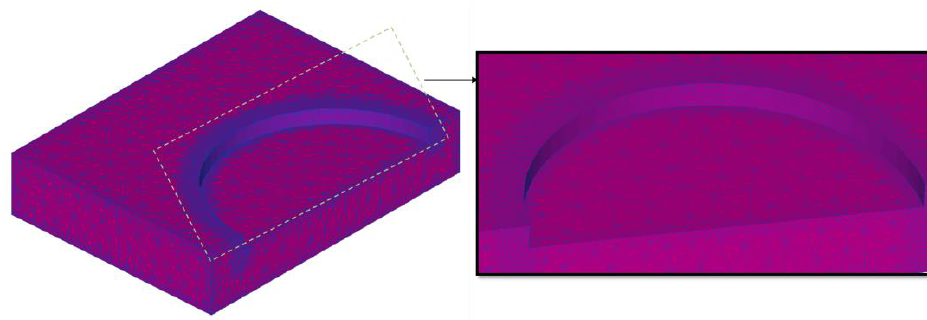
Figure 5. Meshing of the workpiece and enlargement of workpiece edge.